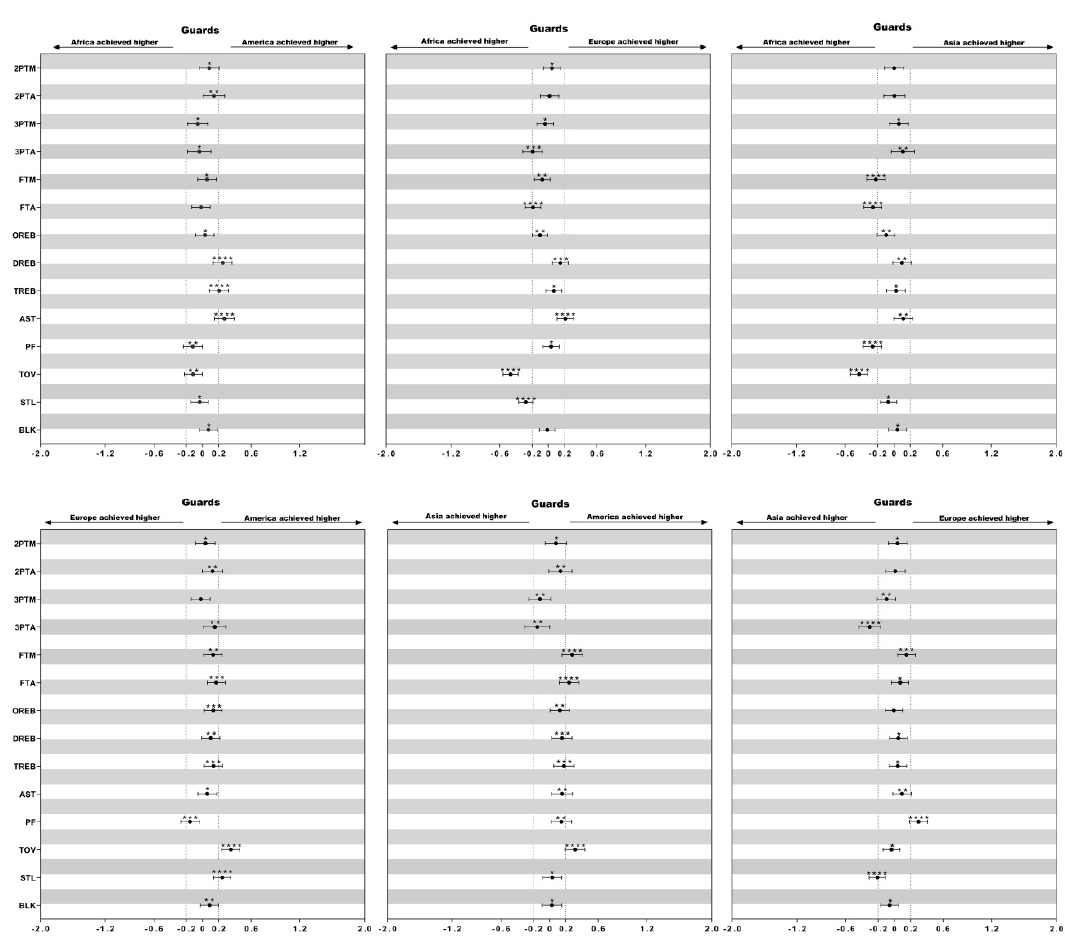
Figure 3. Standardized di ff erences of technical performances in guards among di ff erent continental championships. Bars present 90% confidence intervals. Asterisks indicate the likelihood for the magnitude of the true di ff erence as follows: * possible; ** likely; *** very likely; **** most likely. Asterisks located in the area between − 0.2 and 0.2 denote for trivial di ff erences.